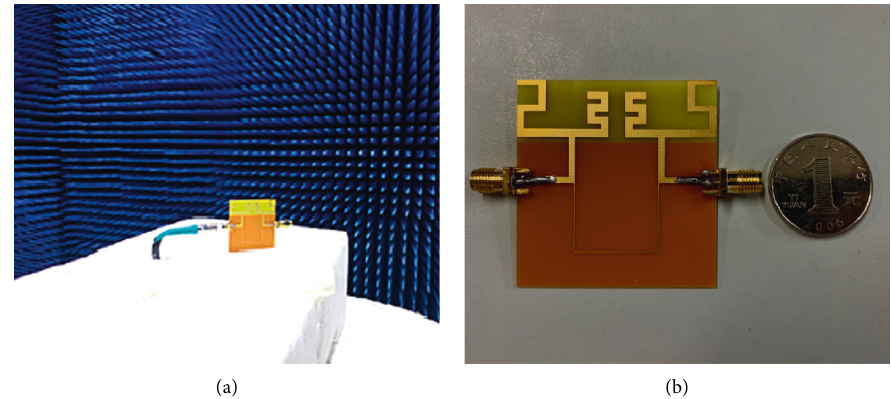
Figure 15: Fabricated prototype of the dual-band antenna#2: (a) testing environment and (b) front view.